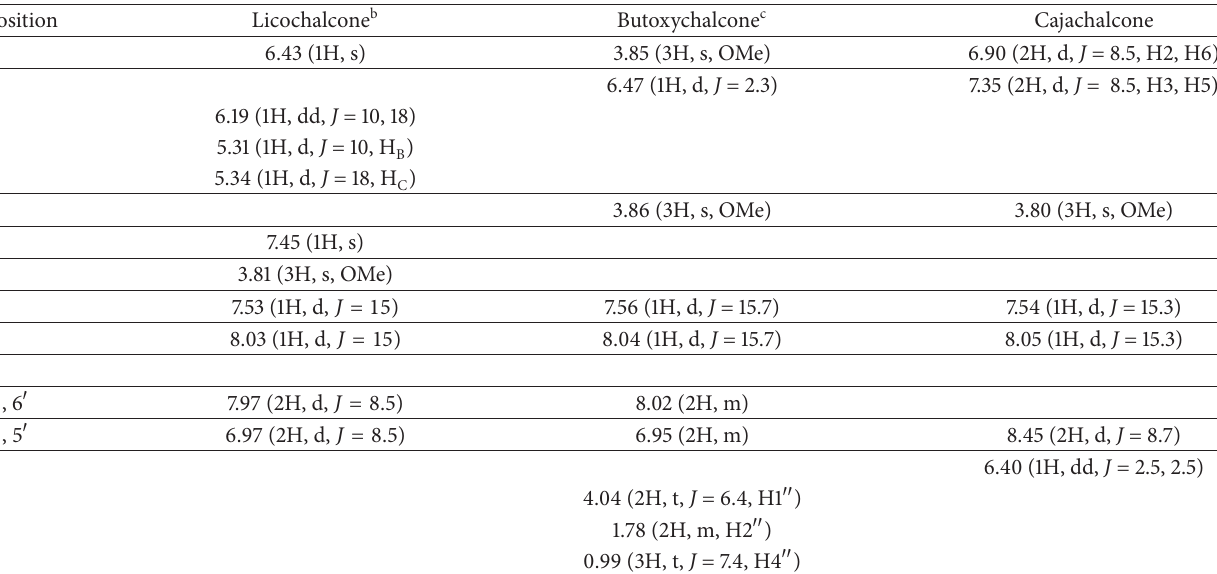
Table 2: Proton- 1 H NMR data of chalcones a